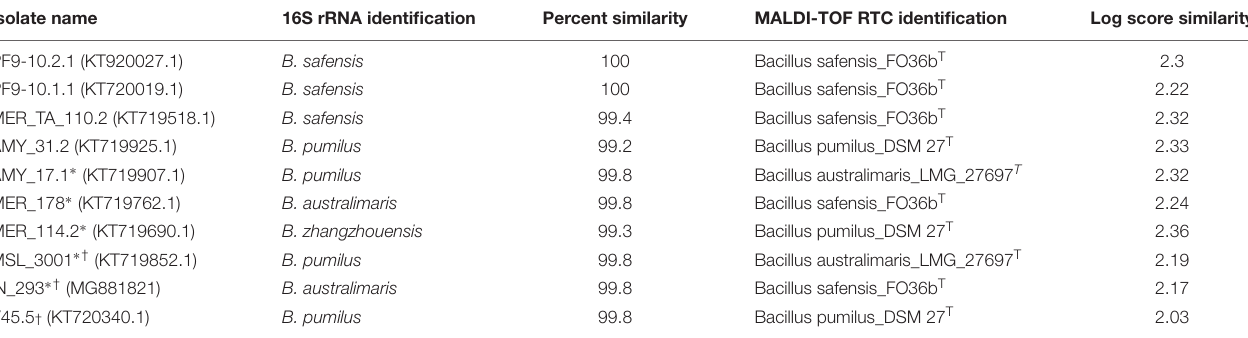
TABLE 1 | Comparative taxonomic identification of 10 bacterial isolates belonging to the Bacillus pumilus taxonomic group (comprised of B. pumilus, B. safensis, B. zhangzhouensis , and B. australimaris ). MALDI-TOF MS analysis was able to resolve taxonomic identifications of isolates that are indistinguishable by 16S rRNA